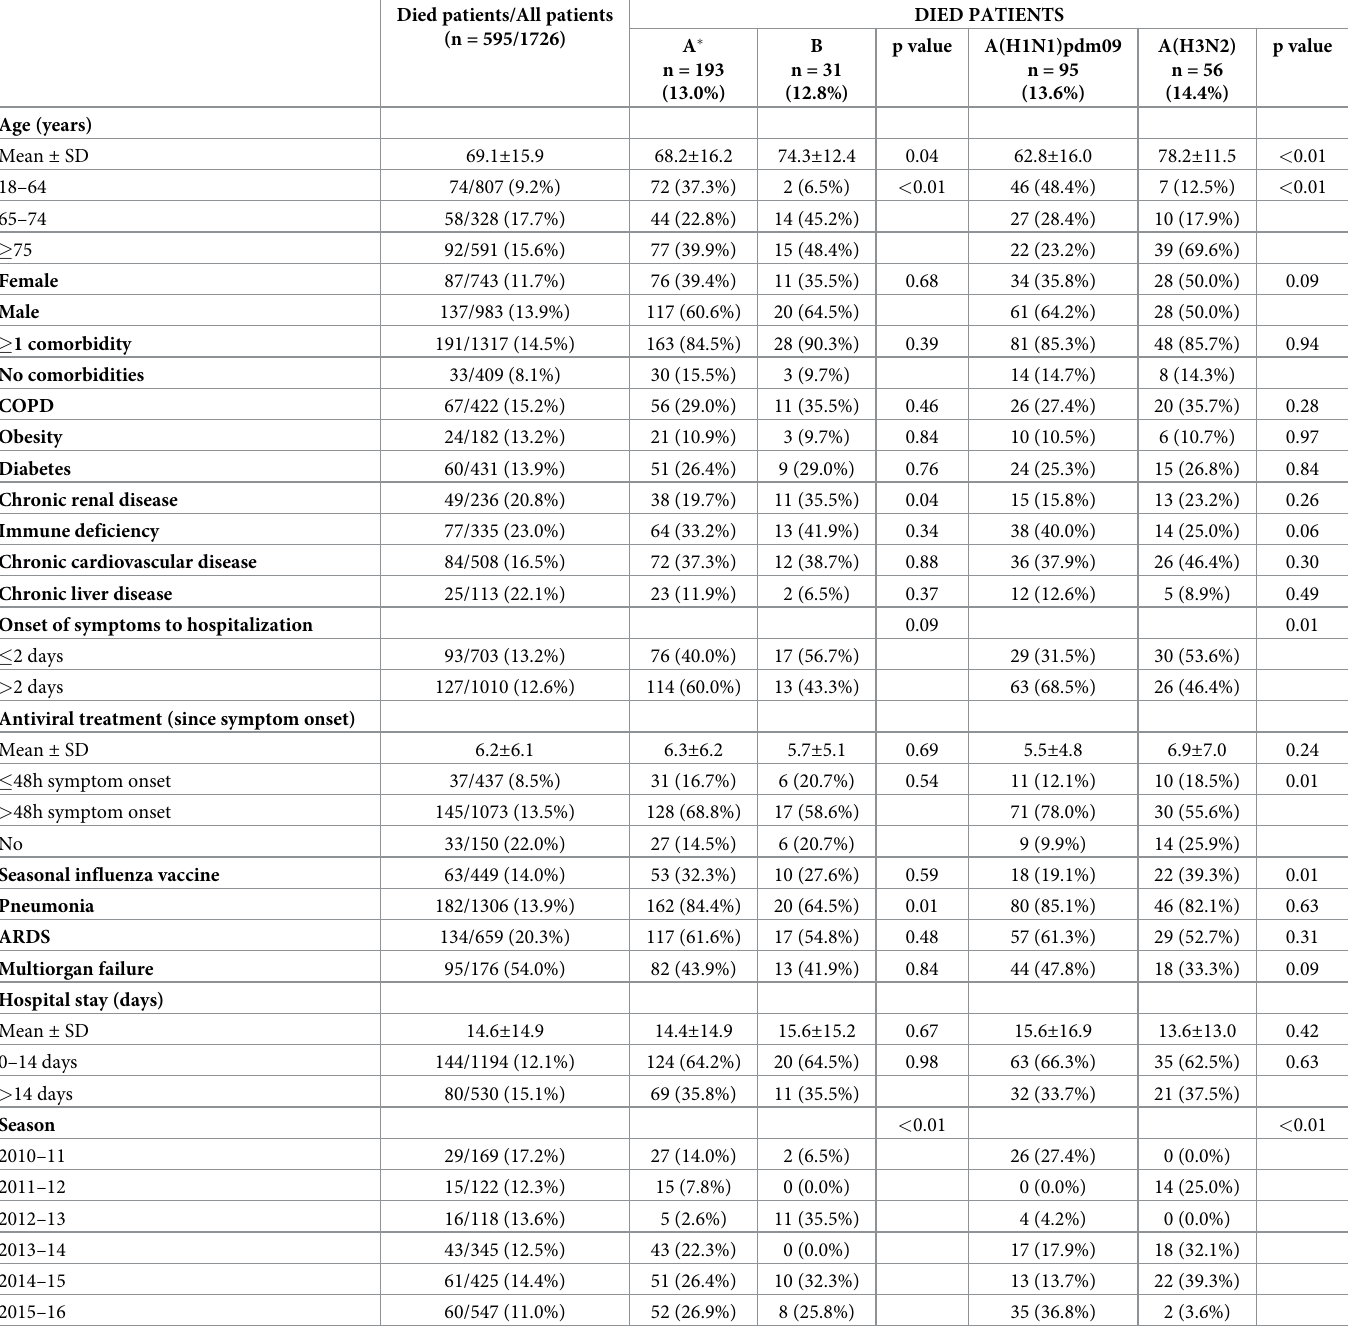
Table 3. Factors associated with death in hospitalized patients according to influenza type and